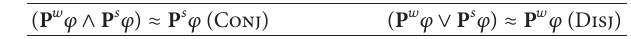
Table 2: Reduction rules of (Conj) and (Disj).